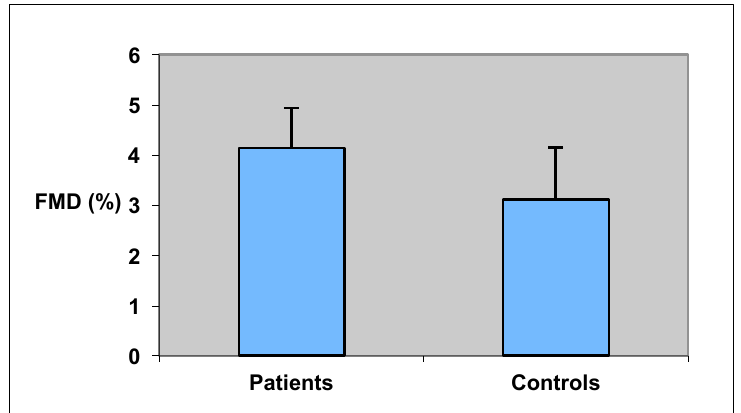
Figure 1. FMD and NMD of the brachial artery and mean IMT of the carotid arteries in patients and controls. Data are mean and error bars indicate SEM. The three parameters do not differ significantly between patients and